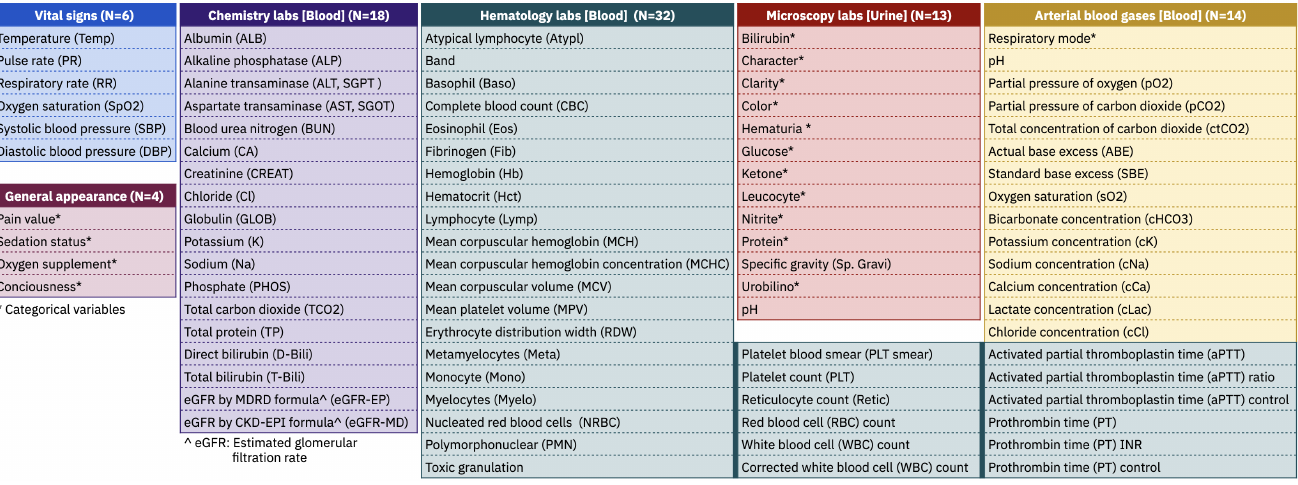
Figure 1. Clinical variables in our dataset.